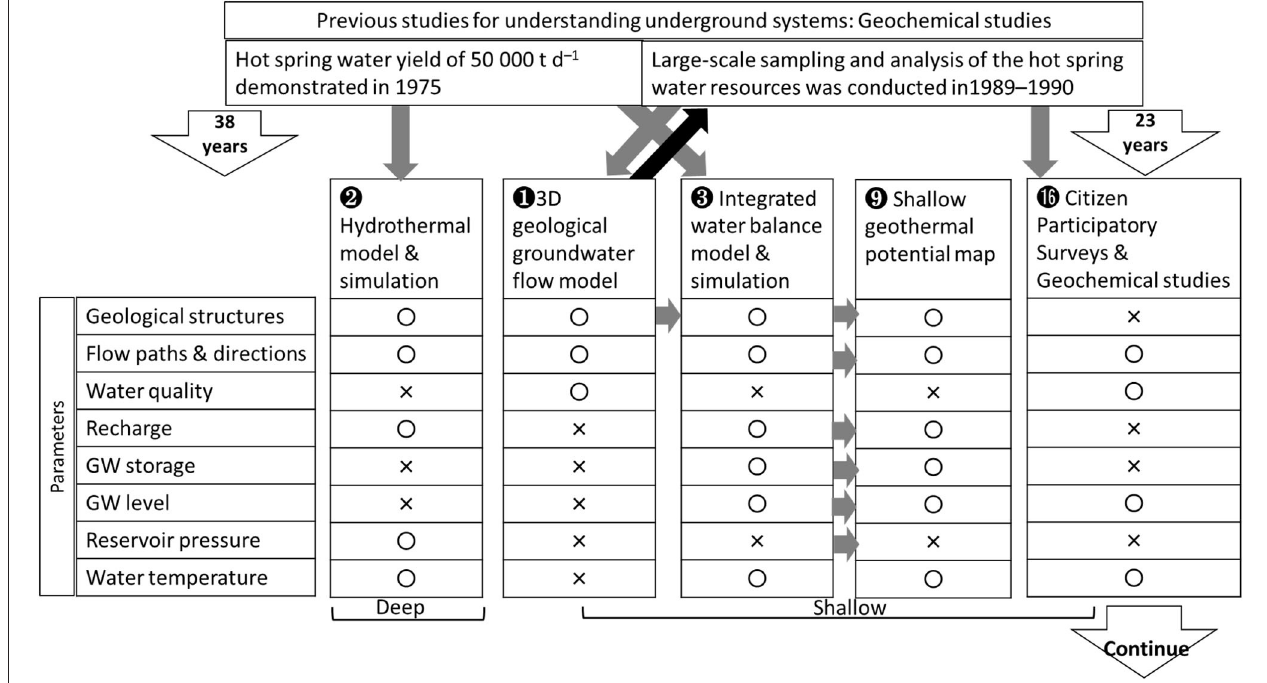
FIGURE 10 | Horizontal integration with different methods for better understanding of the underground system. GW,